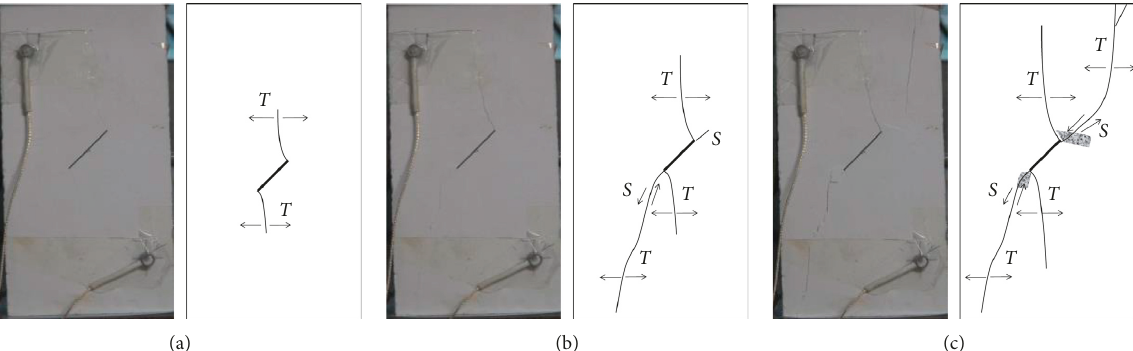
Figure 8: Crack propagation process of sample 45-1 under uniaxial compression: (a) wing crack initiation and propagation; (b) secondary crack initiation and propagation; (c) ultimate failure.